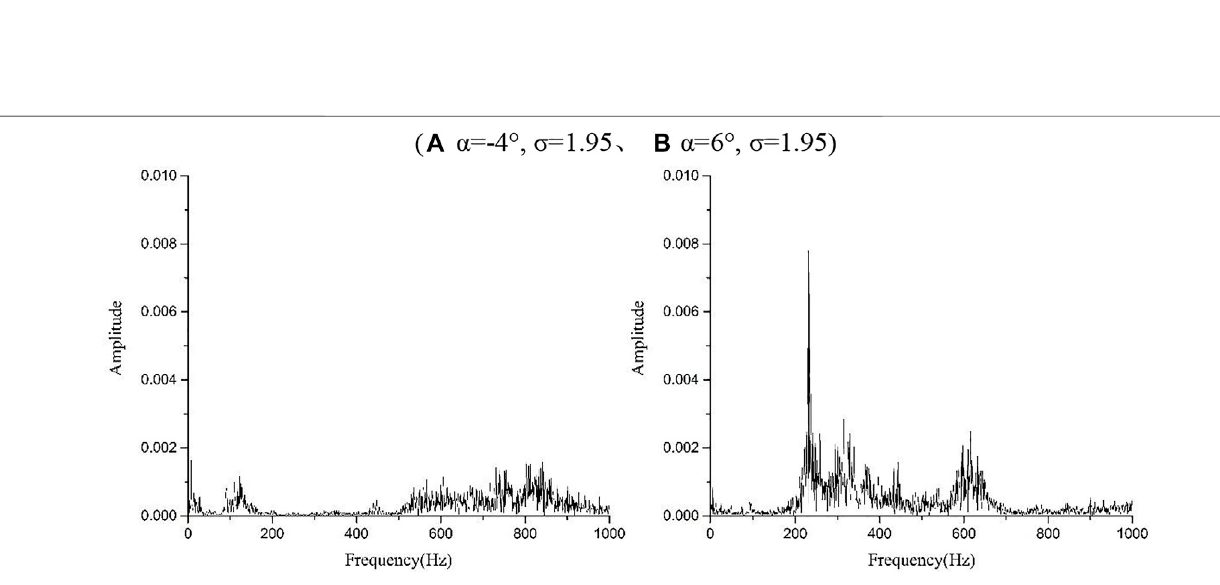
Frontiers in Energy Research |